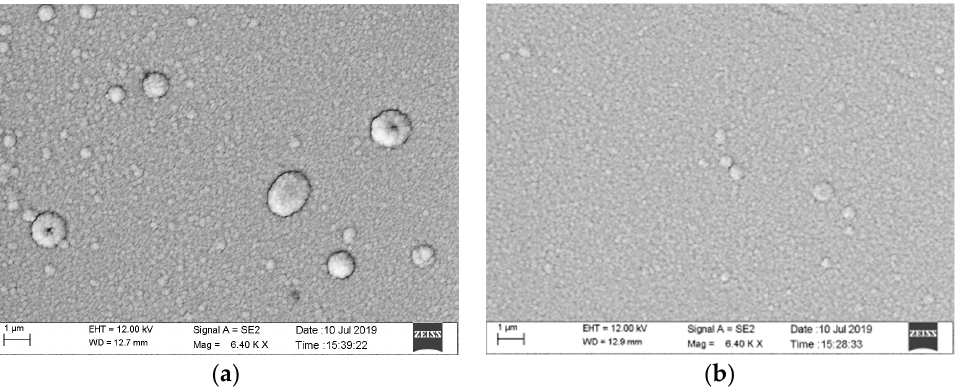
Figure 13. SEM image of Ni Cr thin-film. ( a ) SEM image of NiCr thin-film without surface temperature. ( b ) SEM image of NiCr thin-film with surface temperature.